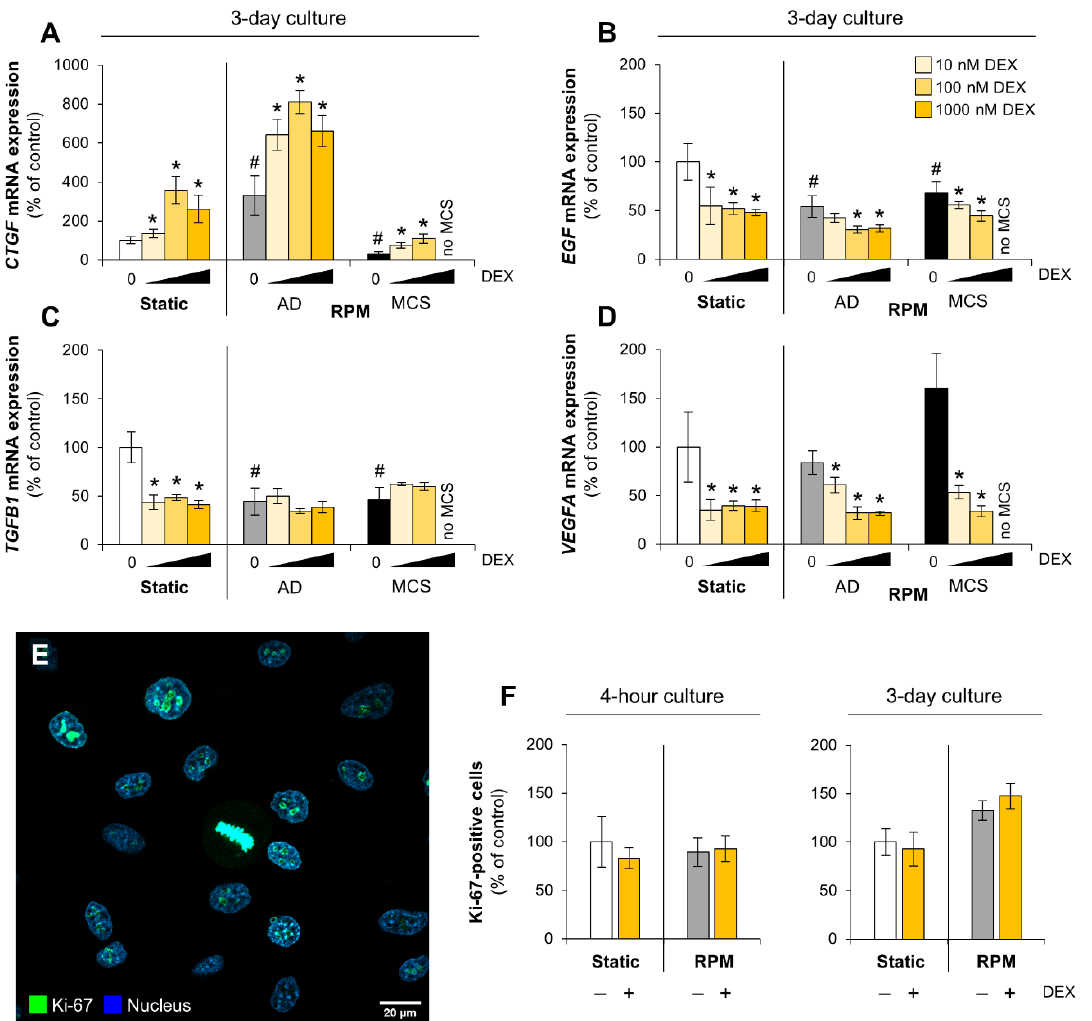
Figure 5. Effect of DEX on autocrine growth factors and proliferation markers in FTC-133 cells. ( A ) CTGF mRNA expression; ( B ) EGF mRNA expression; ( C ) TGFB1 mRNA expression; ( D ) VEGFA mRNA expression. Depicted are means of relative mRNA levels ± standard deviations ( n = 5); ( E ) Immunofluorescence. Nuclear expression of Ki-67 indicates proliferating cells; ( F ) Proliferation